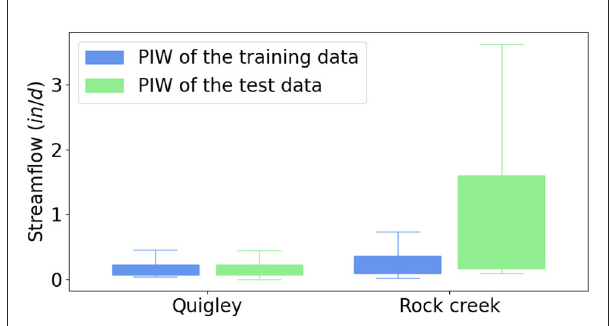
FIGURE3 Prediction interval width (PIW) of the training and test data for the Quigley and Rock creek catchments in ERW. The similar PIW between the training and test data in Quigley indicates that the prediction for the test period can be trusted. In contrast, the largely different PIW between the training and test data in Rock creek suggests that its test period encounters some new climates that have not been seen before in training and the ML predictions may not be